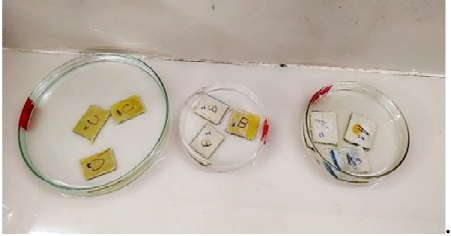
Figure 4. Specimens for the water absorption test using the ASTM D-570 standard.